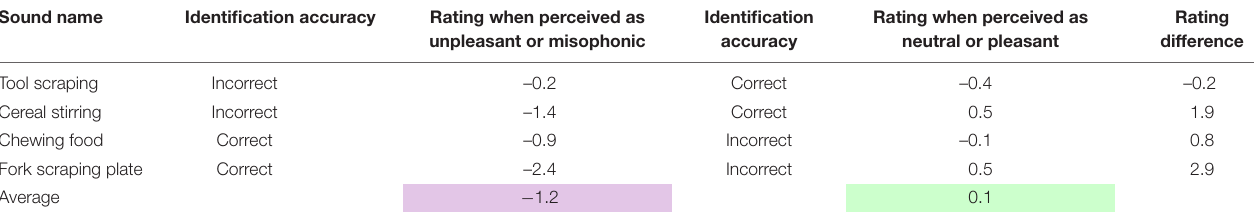
TABLE 5 | Mean pleasantness ratings for the most frequently misidentified sounds in Experiment 1 as a function of how they are